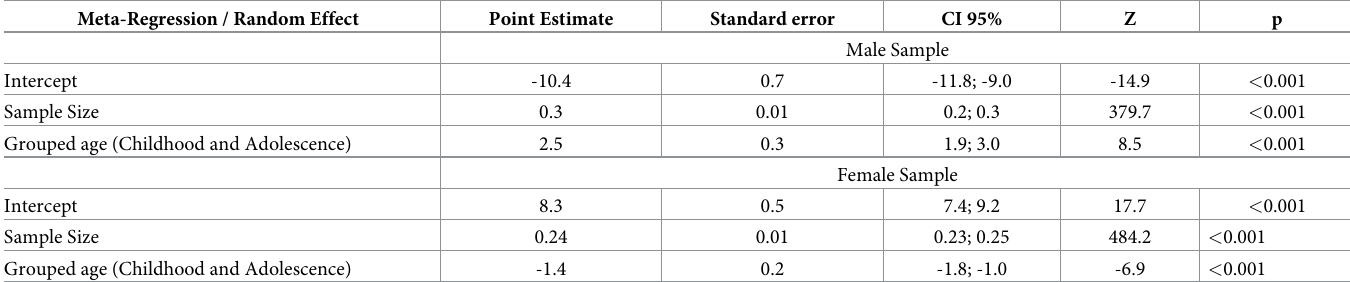
Table 3. Meta-regression analyses to justify the heterogeneity found among the studies in the meta-analyses regarding the different age groups (childhood and adolescence).